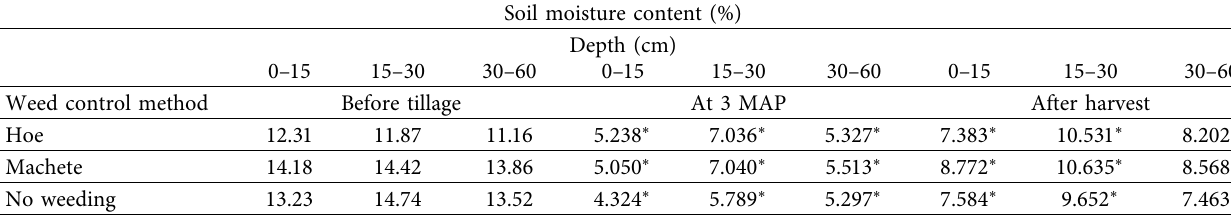
Table 5: Weed control Method’s effect on soil moisture content.